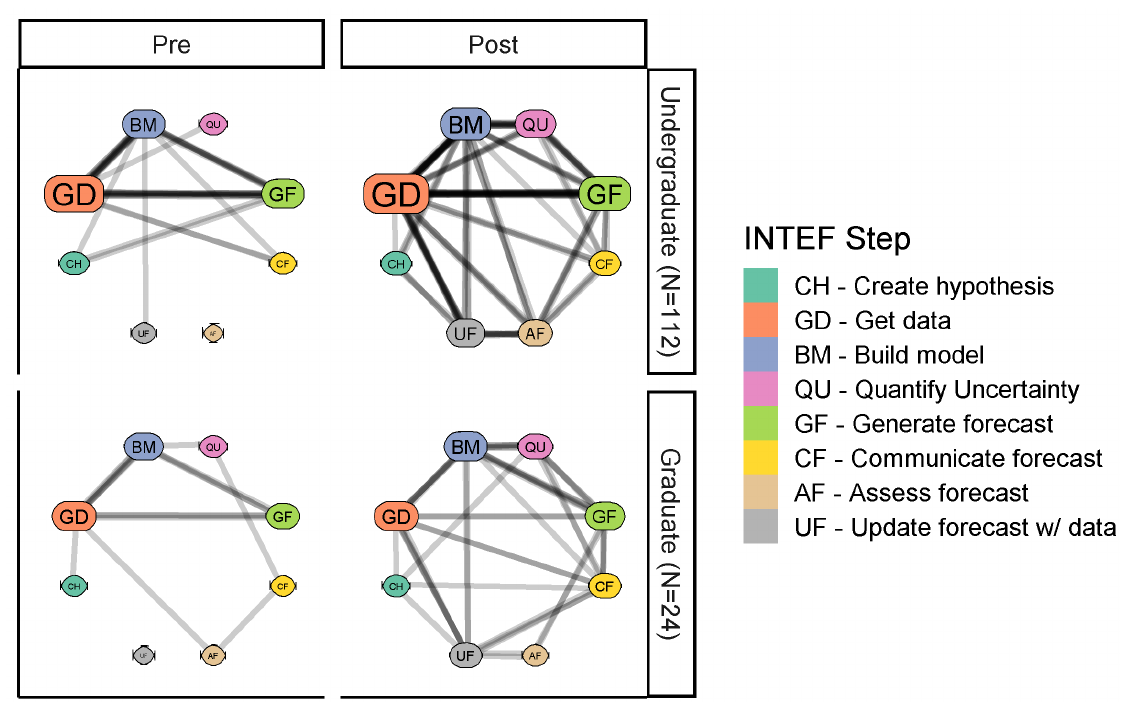
Figure 5. Network diagrams representing the steps of the iterative near-term ecological forecast (INTEF) cycle (corresponding to Figure 1) that undergraduate ( n = 112) and graduate students ( n = 24) included in their pre- and post-module assessment responses to the question about how they would forecast lake algae. The size of the nodes is sized to the number of students which included that step in their responses; the darkness of the edges connecting the nodes is sized to the number of students who included both steps.